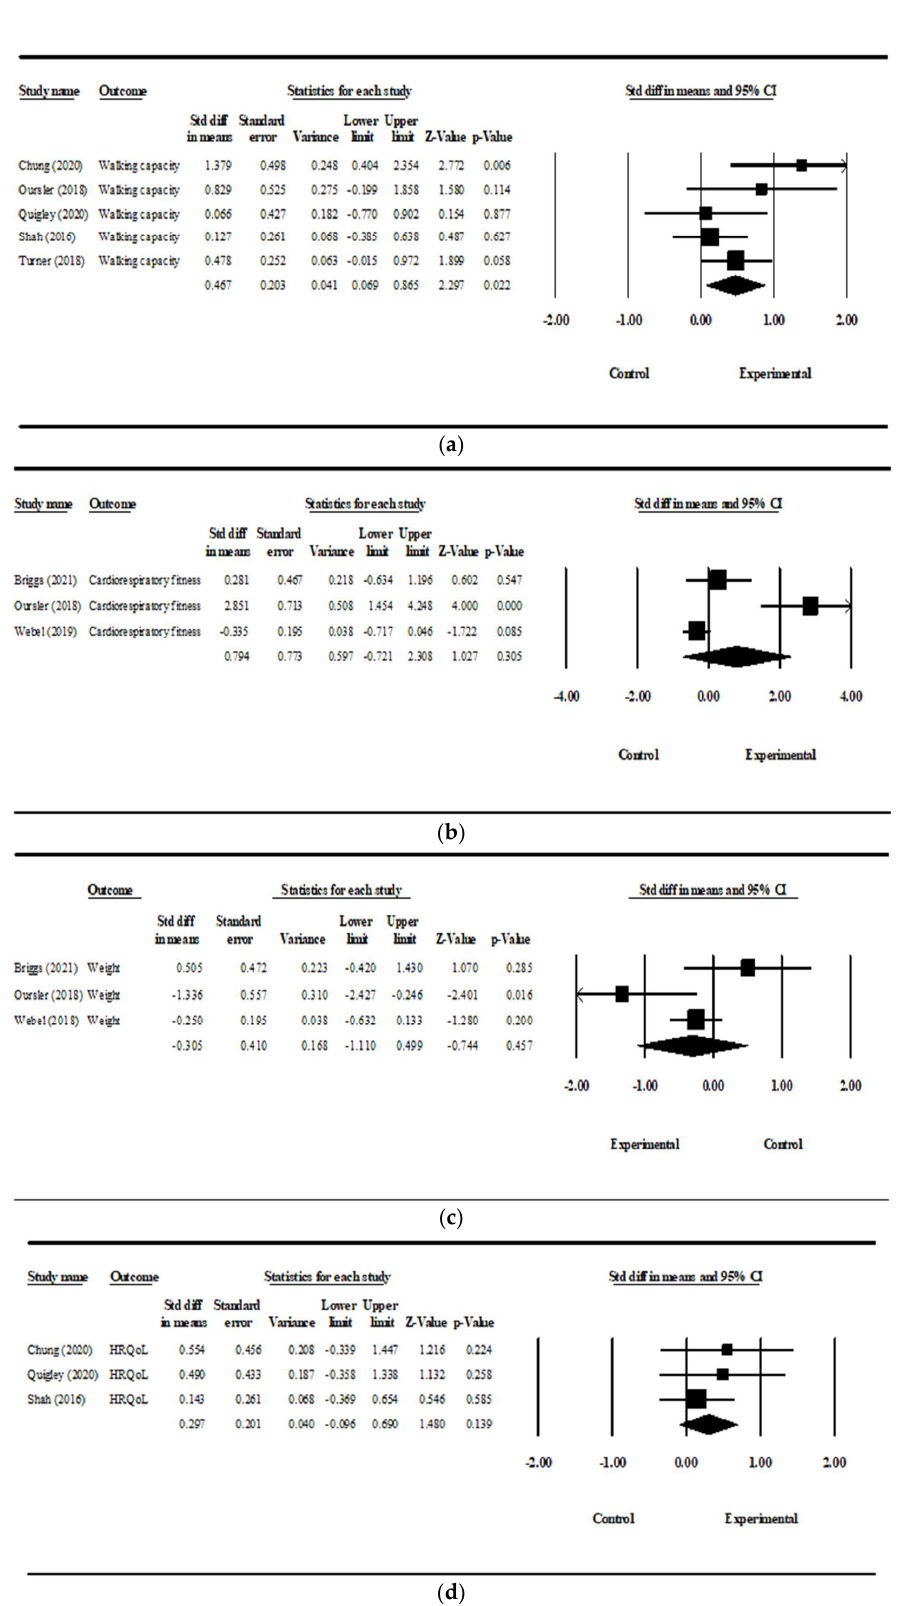
Figure 3. Forest plots showing the effect sizes of physical activity interventions. ( a ) Effect size on walking capacity [17,19,33,36,37]; ( b ) effect size on cardiorespiratory fitness [16–18]; ( c ) effect size on weight [16,17,38]; ( d ) effect size on health-related quality of life